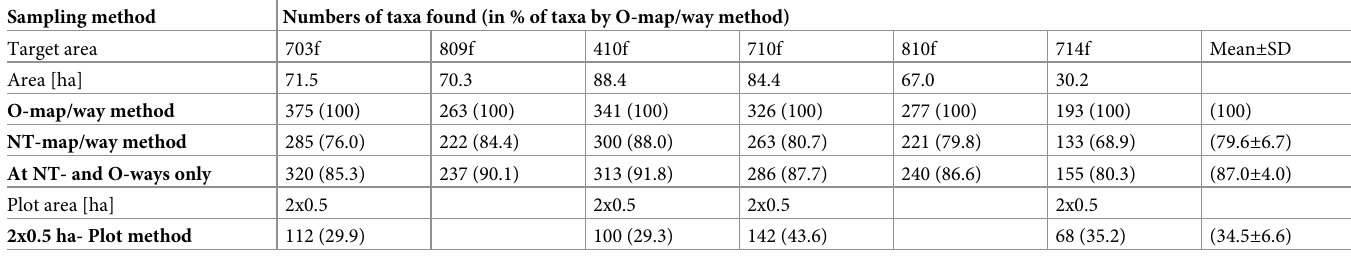
Table 1. The numbers of plant taxa found during 3 seasonal inspection rounds by different sampling methods. Sampling